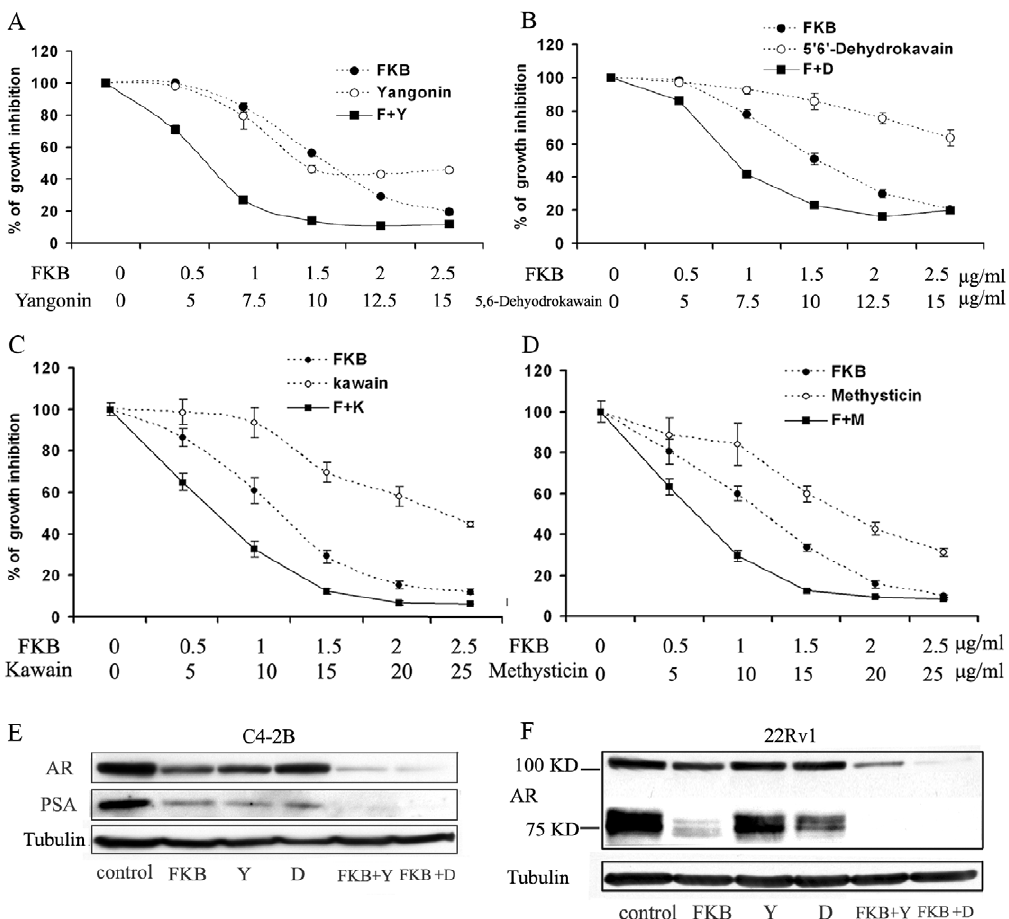
Figure 6. FKB and yangonin or 5 9 6;-dehydrokawain act synergistically to reduce the growth of C4-2B cells and down-regulate the expression of the full-length AR and an AR splice variant. The growth inhibitory of FKB and yagonin ( A ), or 5 9 6;-dehydrokawain ( B ), or kawain ( C ), or methysticin ( D ) alone and in combination on C4-2B cells. Each point is the mean of four independent experiments; bars, SD. Each sample was counted in duplicate. IC 50 s were estimated by dose-response curves, IC 50 s of the combinations are significantly lower than those of the treatments alone (Student t test, P , 0.01).( E ) and ( F ) Westernblottinganalysis ofexpressionofthe full-lengthAR (110 KDa),the AR splicevariant (83 KDa) andPSA inC4-2B and 22Rv1 cells, respectively. A representative blot was shown from three independent experiments. a -Tubulin was detected as a loading control.